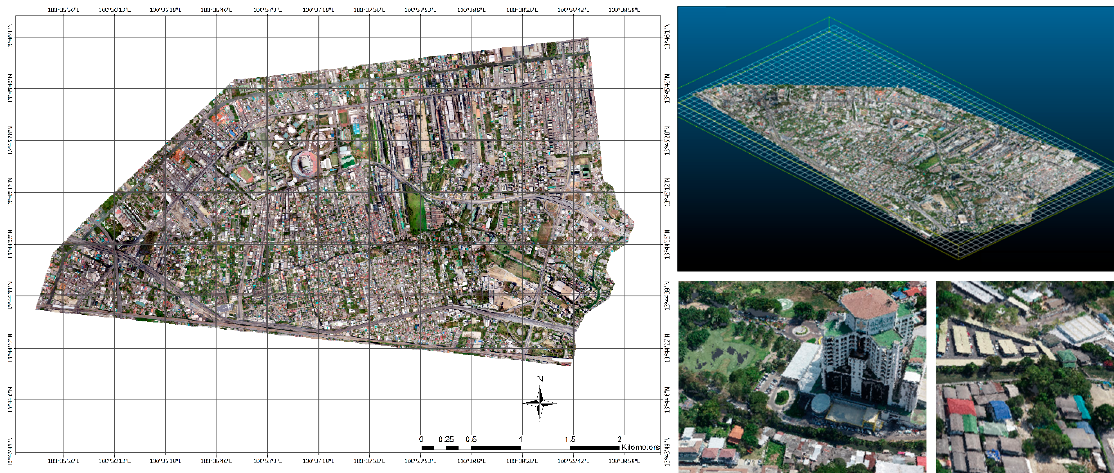
Figure 7. Digital Elevation Model (DEM) of the Ramkhamhaeng polder, Bangkok, Thailand.